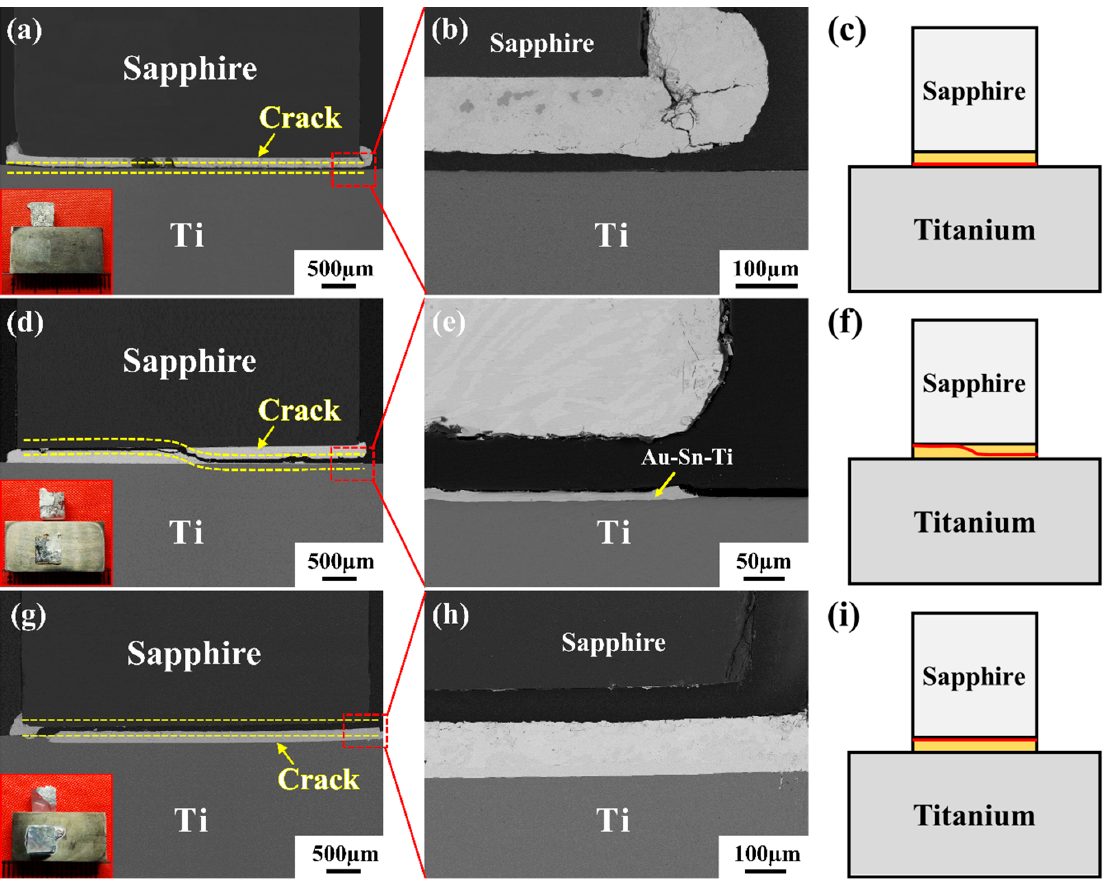
Figure 9. Fracture cross-section of the joints at ( a , b ) 450 °C, ( d , e ) 550 °C, and ( g , h ) 650 °C and diagram of fracture paths at ( c ) 450 °C, ( f ) 550 °C, and ( i ) 650 °C.